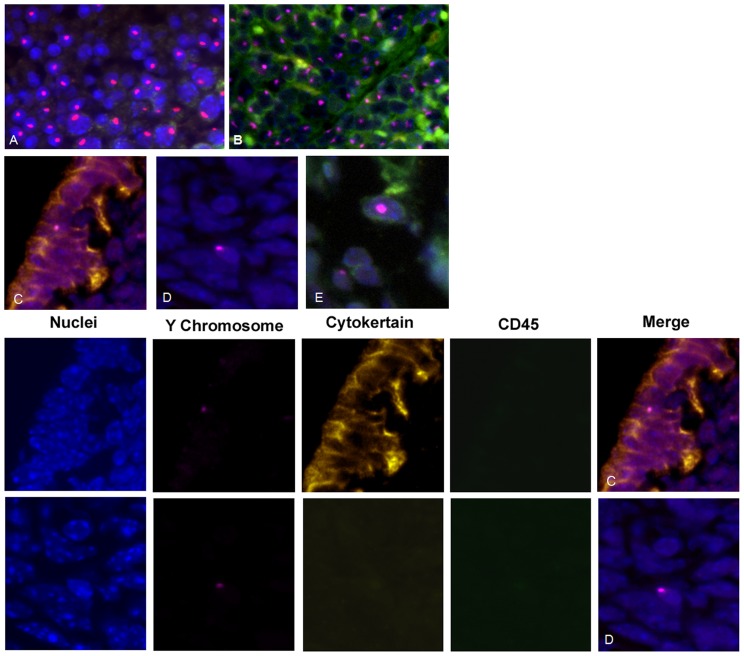
Localized uterine damage recruits BMDSCs throughout the endometrium.Immunofluorescence staining of Y chromosome (red) demonstrates male donor-derived BM cells localized in the endometrium of female recipients. Immunofluorescence staining of CD45 (green) distinguishes endometrial cells from leukocytes. Immunofluorescence staining of cytokeratin (yellow) indicates differentiated epithelial cells. DAPI is used to stain nuclei (blue). Top Panel: (A) Y chromosome signal in the testis shown as a positive control. (B) Y chromosome signal in male spleen tissue demonstrating expression of CD45 (pan leukocyte marker). (C) Y chromosome-positive, cytokeratin-positive, and CD45-negative cell, demonstrating a BM-derived endometrial epithelial cell.(D) Y chromosome-positive, cytokeratin-negative, and CD45-negative cell, demonstrating a BM-derived endometrial stromal cell in the endometrium (E) Y chromosome-positive, CD45-positive cell, demonstrating a transient leukocytes present in the endometrium. Lower Panel: Individual fluorescence images that result in merged figures 3 C and D from top panel. DAPI is used to stain nuclei (blue), Y chromosome FISH (red), immunofluorescence staining of cytokeratin (yellow) and CD45 (green) Original magnification, 400X.